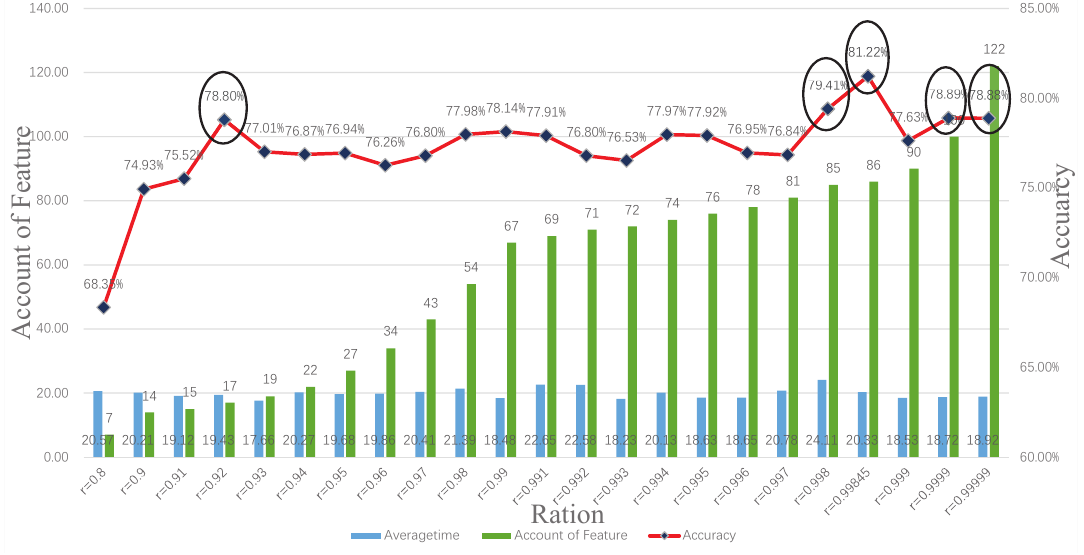
Figure 7. The different ratio of I-ELM+A-PCA